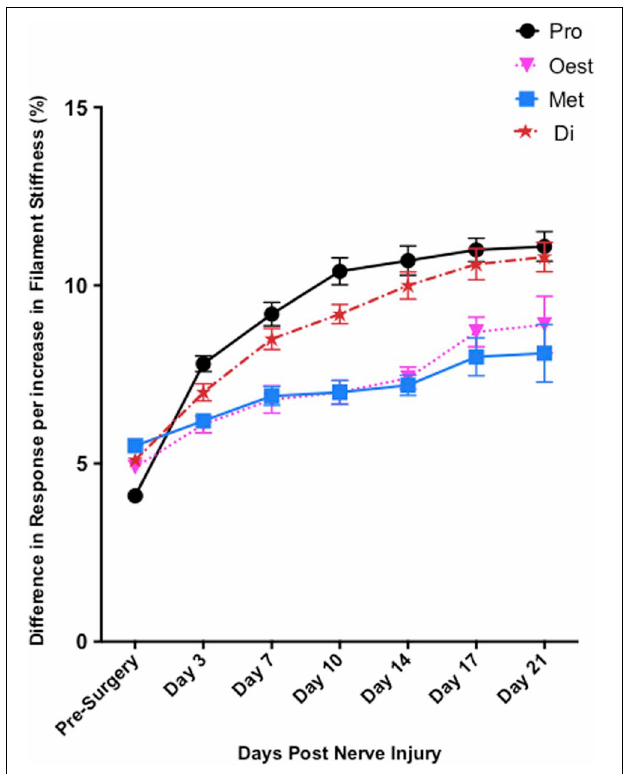
FIGURE 4 | Exacerbated female pain is influenced by the rodent oestrus cycle. von Frey Test 3 demonstrated female mechanical allodynia was heavily dependent on the rodent oestrus cycle. Post nerve injury, moderate pain females (N3S1) were significantly more allodynic during dioestrus and pro-oestrus t = − 7 . 7. The data presented is generated from von Frey Test 3. Results generated by von Frey Test 3 are expressed as the percent difference in response per increase in von Frey hair stiffness. Results were analyzed utilizing repeated measures linear mixed effects modeling. A t -value of < − 2 or > 2 was determined statistically significant ( p < 0 . 05). n = 8 per treatment group. von Frey filaments: 6: 10, 5:6, 4: 2, 3: 1.0, 2: 0.4, 1: 0.07g. Di, dioestrus; met, metoestrus; oest, oestrus; pro, pro-oestrus.